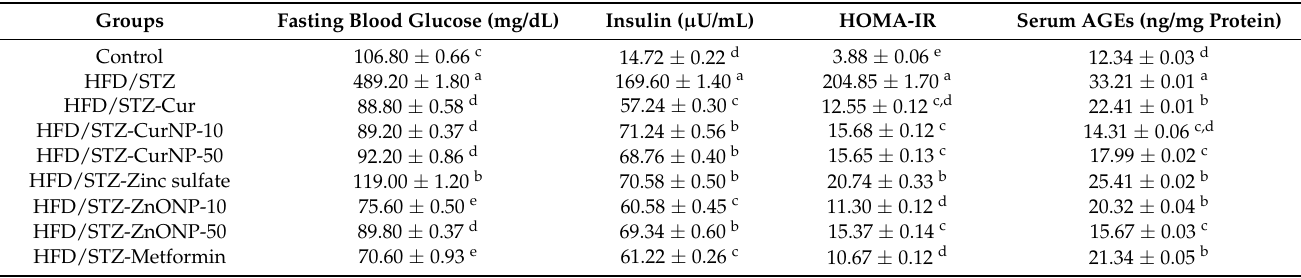
Table 1. Effects of CurNP and ZnONP on the serum fasting blood glucose, insulin, HOMA-IR, and AGEs levels. Groups